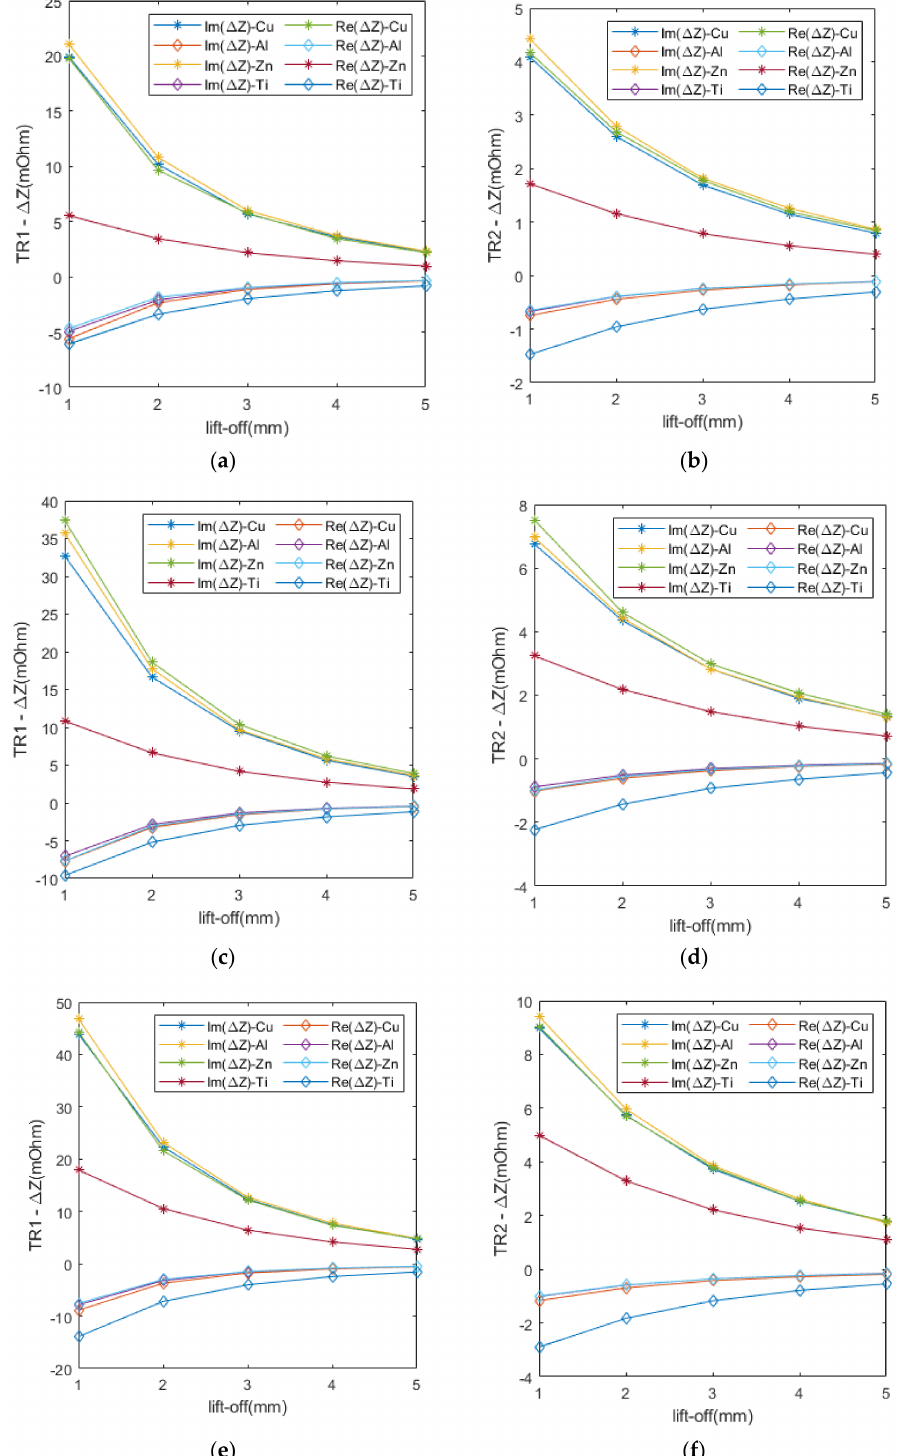
Figure 5. Impedance change in TR1 and TR2 for different metals at different excitation